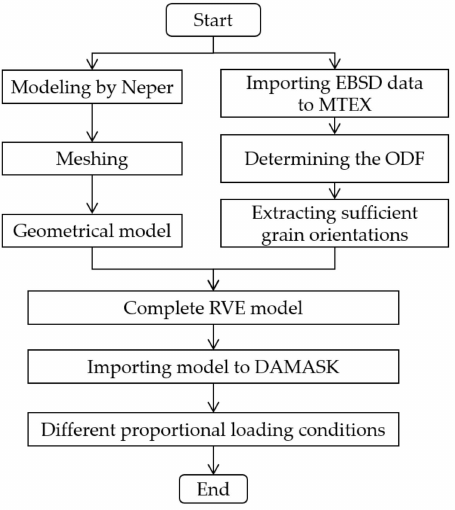
Figure 4. Flow chart of building the complete model and